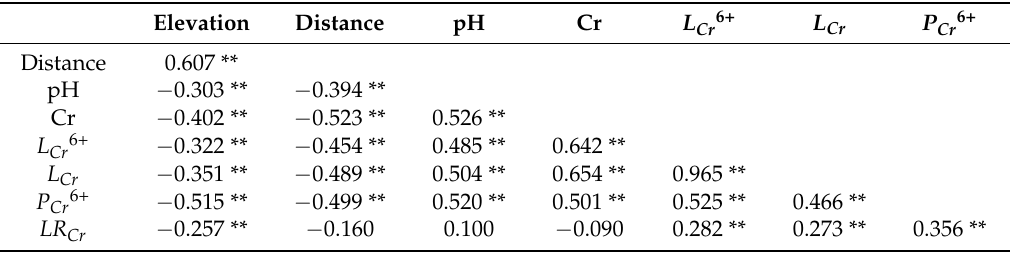
Table 4. Pearson correlation coefficients among general characteristics of surface soils in the study area ( n = 130). Elevation